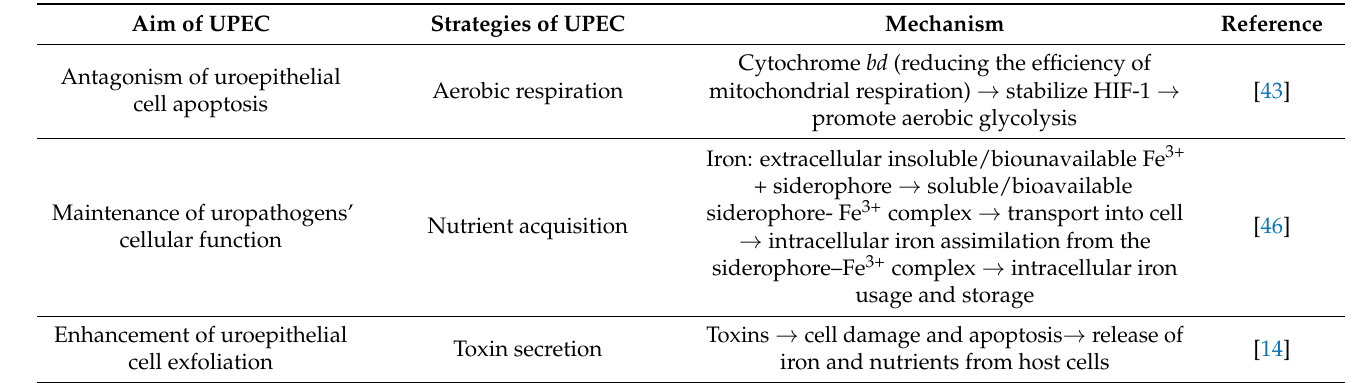
Table 3. Mechanisms of survival of UPEC within urothelial